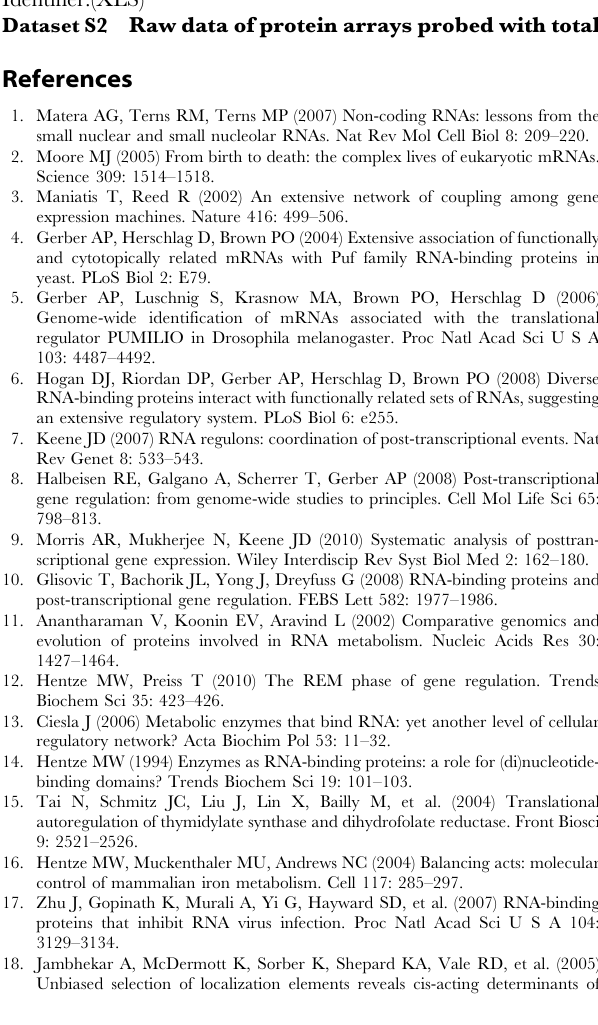
chip experiments are marked next to the gene cluster. The experimental conditions are described in the Table S3. (TIF) Table S1 List of 180 selected proteins interacting with total RNA or mRNA on protein microarrays. Columns indicate the following (from left to right): YORF, gene name, GO annotations, protein interacted with respective RNA on protein microarrays, classified as metabolic enzyme, number of proteins per cell [28], Pfam domains. Proteins used for affinity isolations are labeled in red. Proteins interacting with mRNAs are marked with red-filled boxes; proteins selected with total RNA are in green; yellow are the ones that interacted with both types ofRNA. (XLS) Table S2 Significantly enriched GO terms among proteins interacting with total RNA or mRNA. Table S3 List of conditions for microarray data re- trieved from the M3D database. Table S4 A selection of significantly enriched GO terms among messages associated with proteins. Terms that belong to the GO category ‘Process’ are written in black; GO terms for ‘Function’ are in red, and the ones for ‘Compartment’ are in blue. (XLS) Dataset S1 Raw data for protein arrays probed with E2Bmin RNA. Columns indicate the following (from left to right): YORF, gene name, Z-scores of two protein arrays probed with E2Bmin, mean of Z-scores, Z-scores of heat-treated protein microarray, GO process, function, S. cerevisiae Genome Database Identifier. (XLS) Dataset S2 Raw data of protein arrays probed with